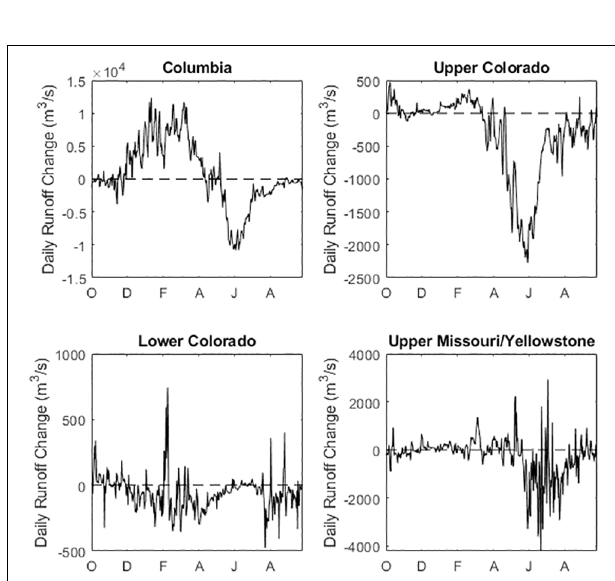
FIGURE 7 | Difference in decade-averaged annual hydrographs for western watersheds. Daily runoff change is calculated by subtracting historic values from end-century